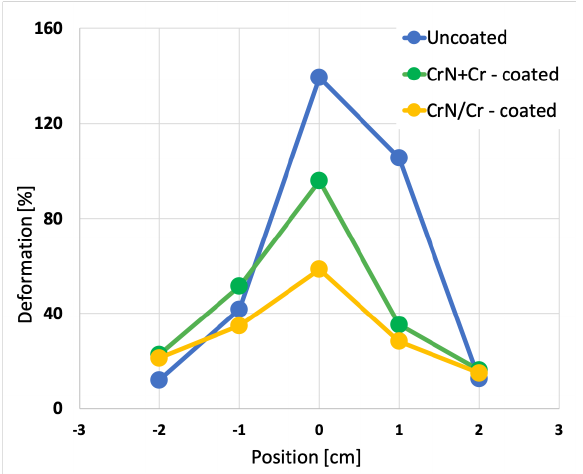
Figure 6. Deformation at temperature 800 ◦ C under inner pressure of 4 MPa in relation to position for different types of coatings and uncoated specimens